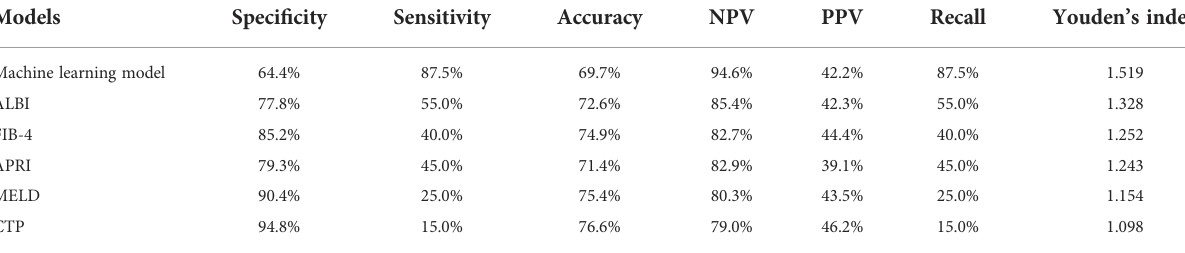
TABLE 4 Predictive power of the ML model and routine clinical models using data of the testing cohort. Models